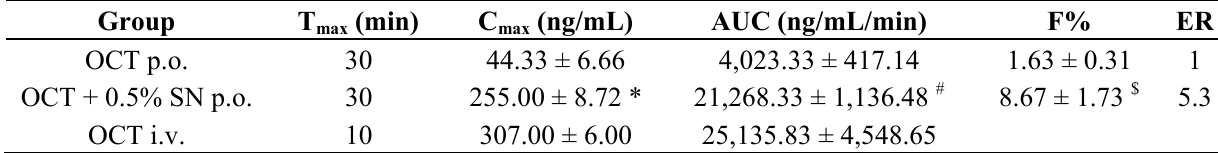
Table 1. The pharmacokinetics parameters of OCT in rats. OCT after i.v. administration showed a single peak immediately at 10 min (T ) with a C of 307 ng/mL, oral max max administration of OCT showed a single peak later at 30 min (T ) with a C of 44.3 ng/mL, max max oral administration of OCT with SN produced an uptake pro fi le at 30 min (T ) with a max of 255 ng/mL. * p (C of OCT + SN group vs . OCT group) < 0.05, # p (AUC of C max max